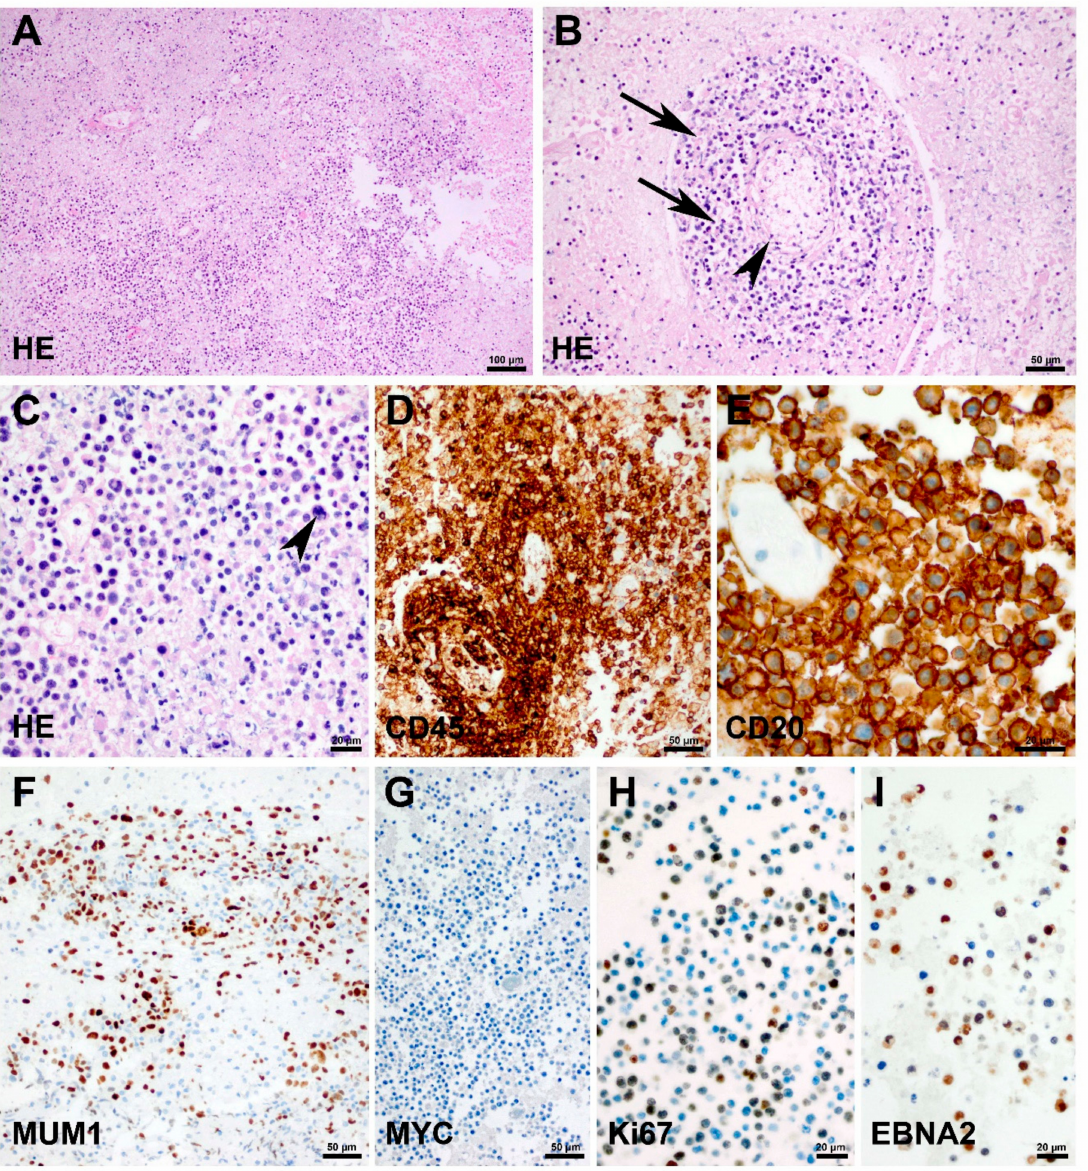
Figure 2. Histopathology of primary central nervous system lymphoma. Hematoxylin and eosin staining of the brain biopsy specimen ( A – C ) shows dense infiltrates of malignant lymphocytes with a characteristic accumulation of tumor cells in the perivascular space ( B , arrows) of small intraparenchymal vessels ( B ; arrowhead). ( C ) The tumor is composed of blasts with large nuclei, prominent nucleoli and frequent mitotic figures (arrowhead). ( D ) Expression of CD45 on malignant B cells. ( E ) Expression of CD20 on malignant B cells. ( F ) Expression of Mum1 on malignant B cells. ( G ) Lack of MYC expression on lymphoma cells. ( H ) High proliferative activity as demonstrated by Ki67/MIB-1 labelling. ( I ) Positive EBNA2 expression as a sign for Epstein–Barr virus infected lymphoma